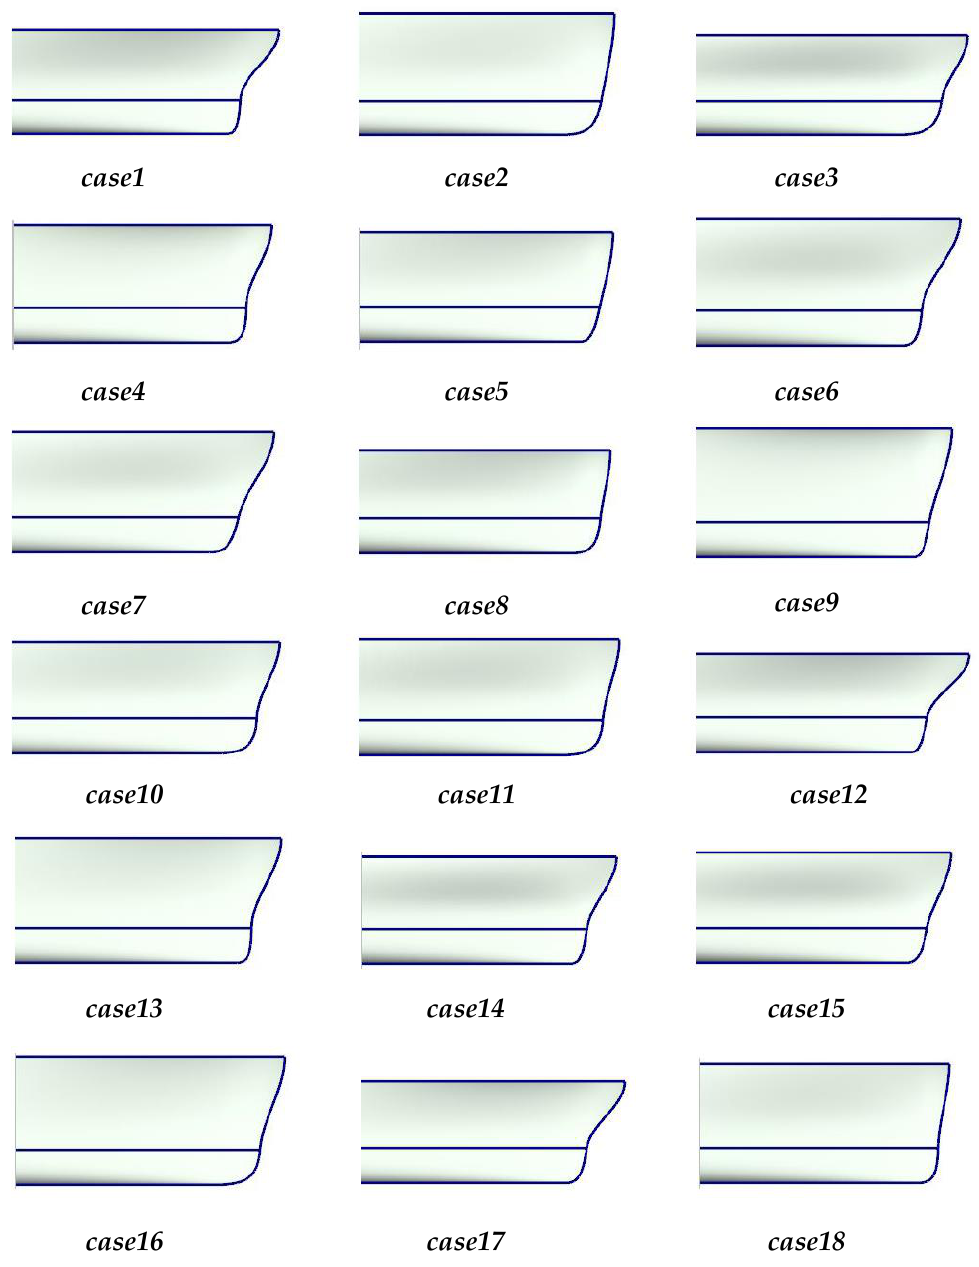
Figure 24. Hull shape in each